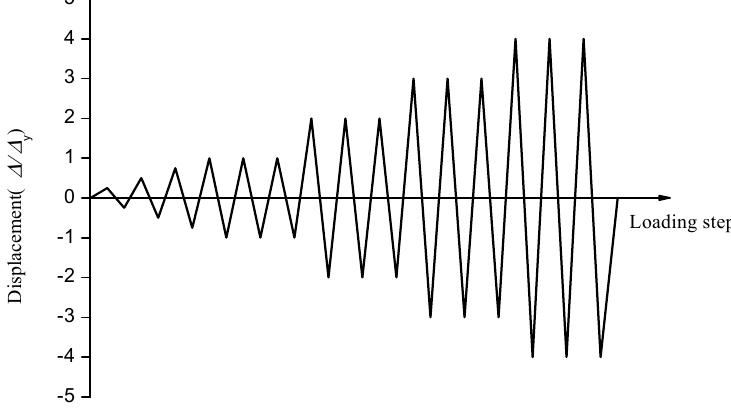
Figure 9. The cyclic loading schedule.